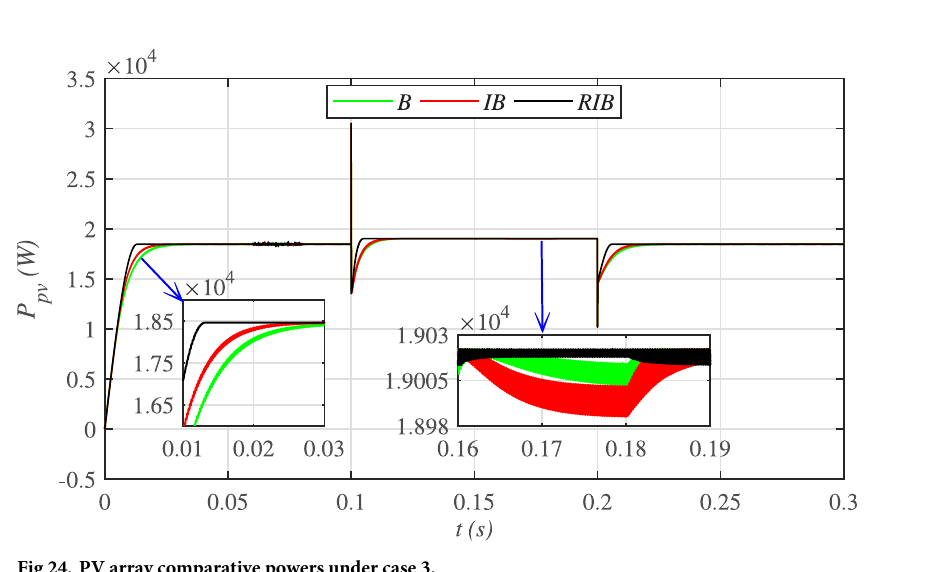
Fig 24. PV array comparative powers under case 3.